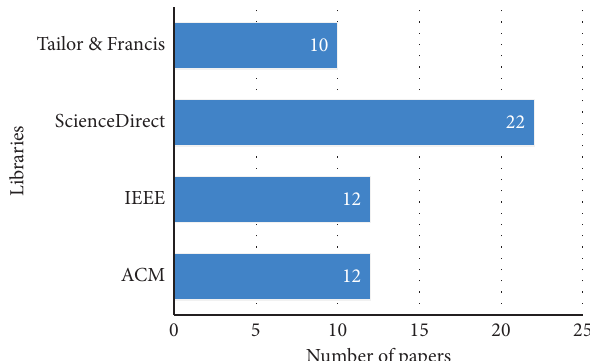
Figure 12: Total papers in the given libraries with the total number of publications.